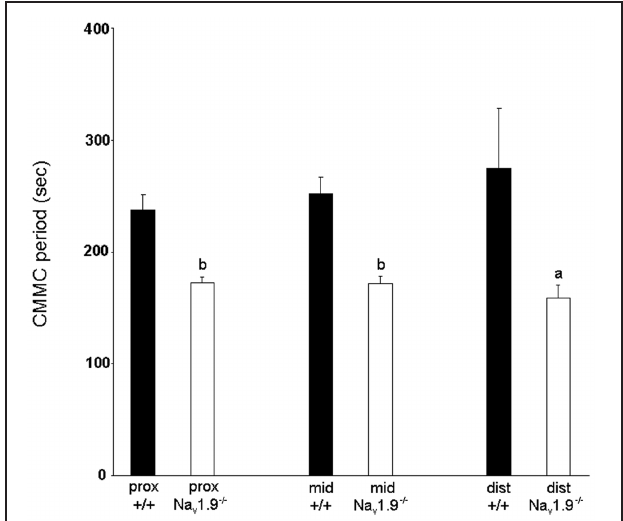
FIGURE 3 | Graphic representation of the period of CMMCs in the proximal, mid- and distal colon of wild-type and Na v 1.9 − / − mice. The period of CMMC in Na v 1.9 − / − mice was found to be significantly shorter than in + / + mice. a P < 0 . 05, b P < 0 . 01 vs. + / + mice.